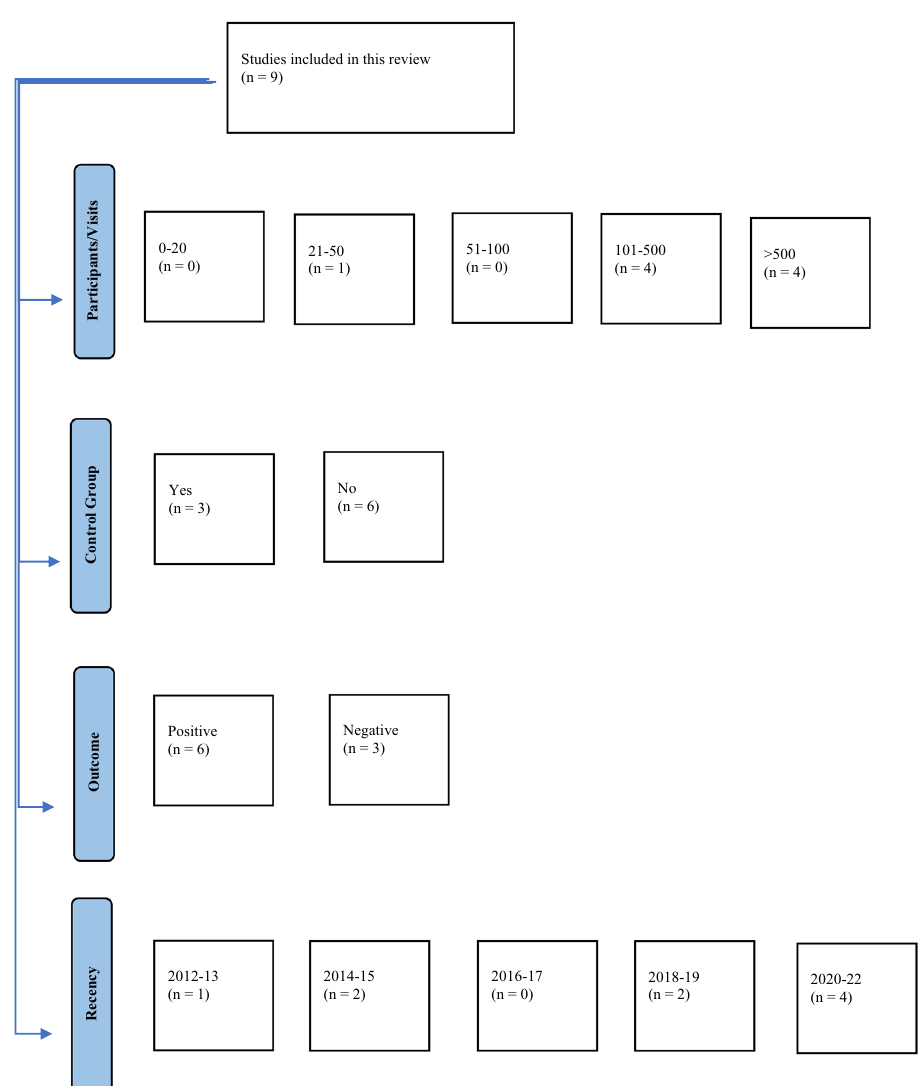
Fig. 1 Articles grouped by study characteristics. The number of articles belonging to each category are shown as n = . Number of ED visits were considered equivalent to number of participants. Articles deemed to have control groups were those with comparator groups (e.g. nurse-led triage). The positive and negative classi fi cation included articles where there was a mix of both outcomes (with the more predominant outcome favoured). Categories for recency of publication were divided into 2-year groups (excluding the last category since the search was completed in early